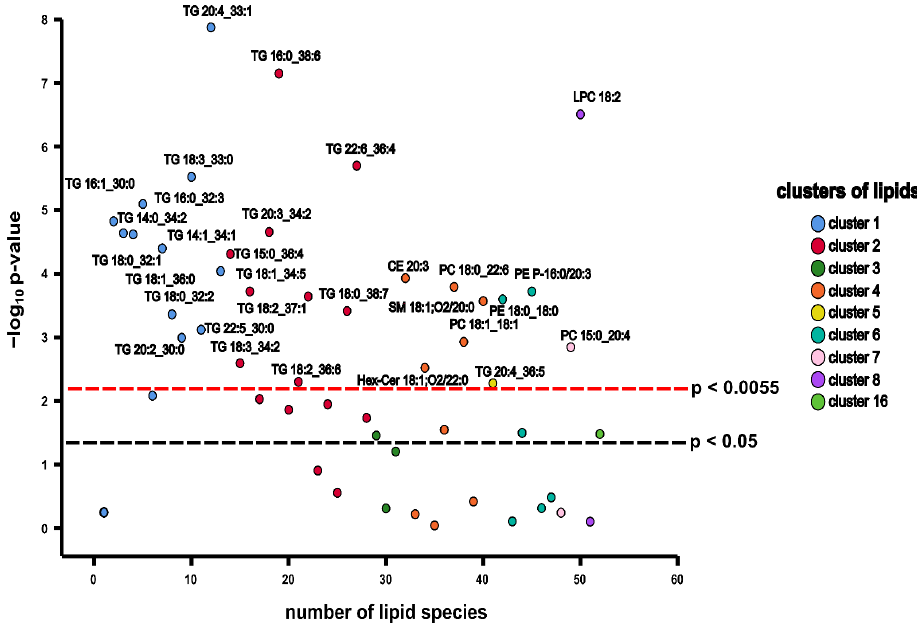
Figure 4. The Manhattan plot of the results from stepwise regression analysis of identified clusters. Each point indicates the negative log 10 of p values obtained in the adjusted regression analysis of individual lipid species. Black dashed line corresponds to the significance level of p < 0.05. Red dashed line corresponds to the Bonferroni-adjusted significance level of p < 0.0055. Names of only those lipid molecules showing a significant association with BMI after Bonferroni correction are indicated. Abbreviations: CE=cholesterolester, HexCer=hexosylceramide, LPC=lysophosphatidylcholine, PC=phosphatidylcholine, PE=phosphatidylethanolamine, PE P= plasmenylethanolamine, SM=sphingomyelin, TG=triacylglycerol.